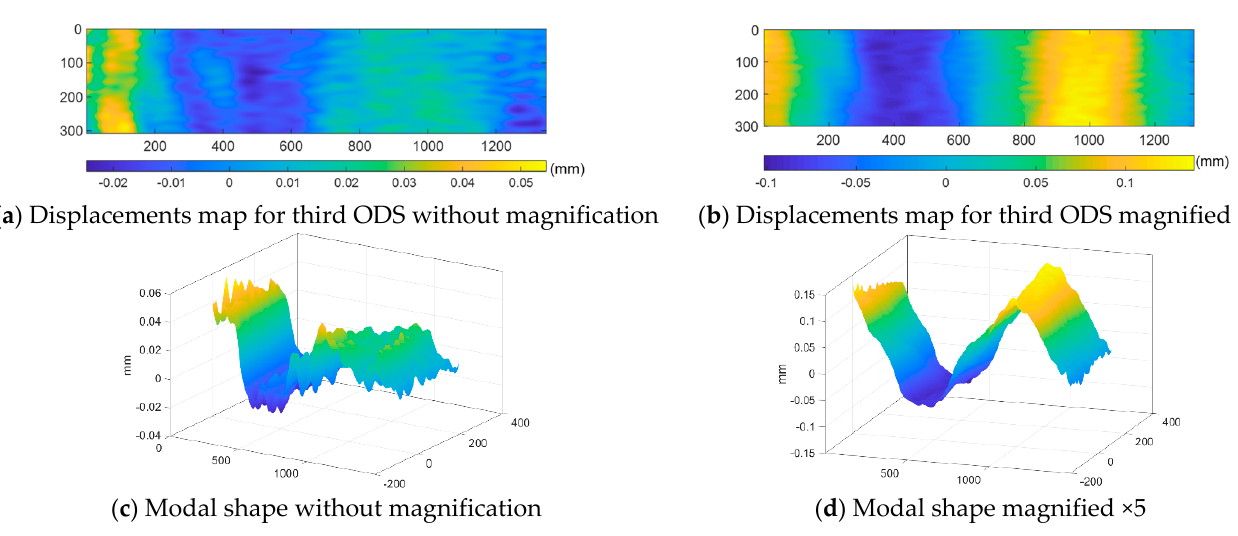
Figure 7. Comparison of maps displacement and mode shapes before and after magnifying.